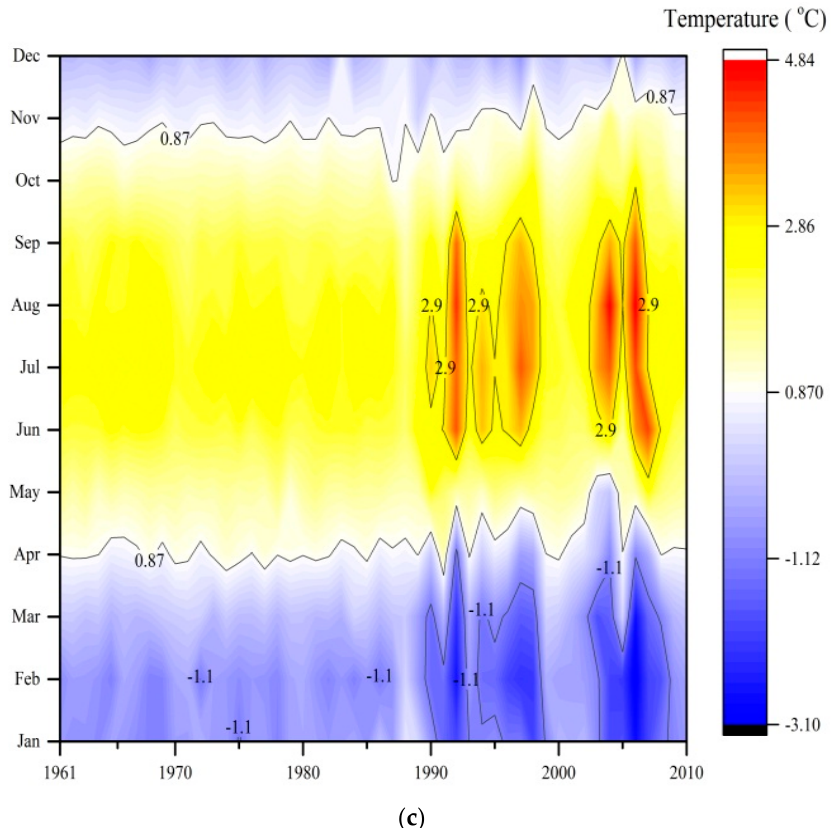
Figure 14. Contours of Parde co-efficient precipitation, runoff and temperature of zone I. ( a ) precipitation ( b ) runoff ( c ) temperature.